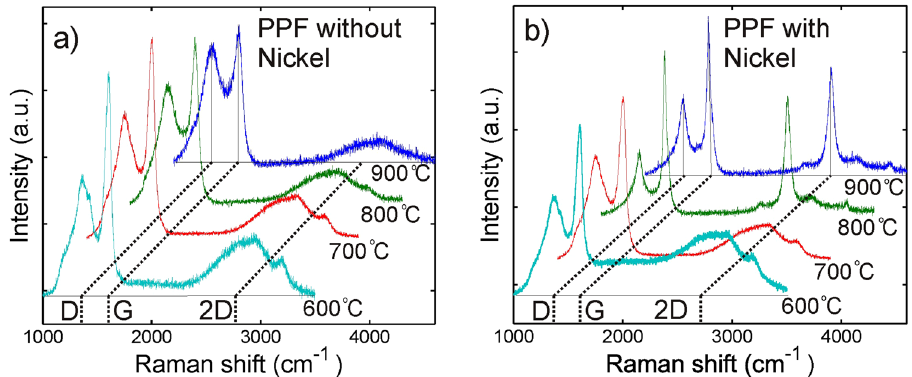
Figure 3. Raman spectra of carbon films fabricated at different temperatures with and without a Ni film. ( a ) Raman spectra of PPF correspond to very amorphous carbon material and show minor changes temperature is increased. ( b ) Raman spectrum PPF + Ni changes drastically between 700 °C and 800